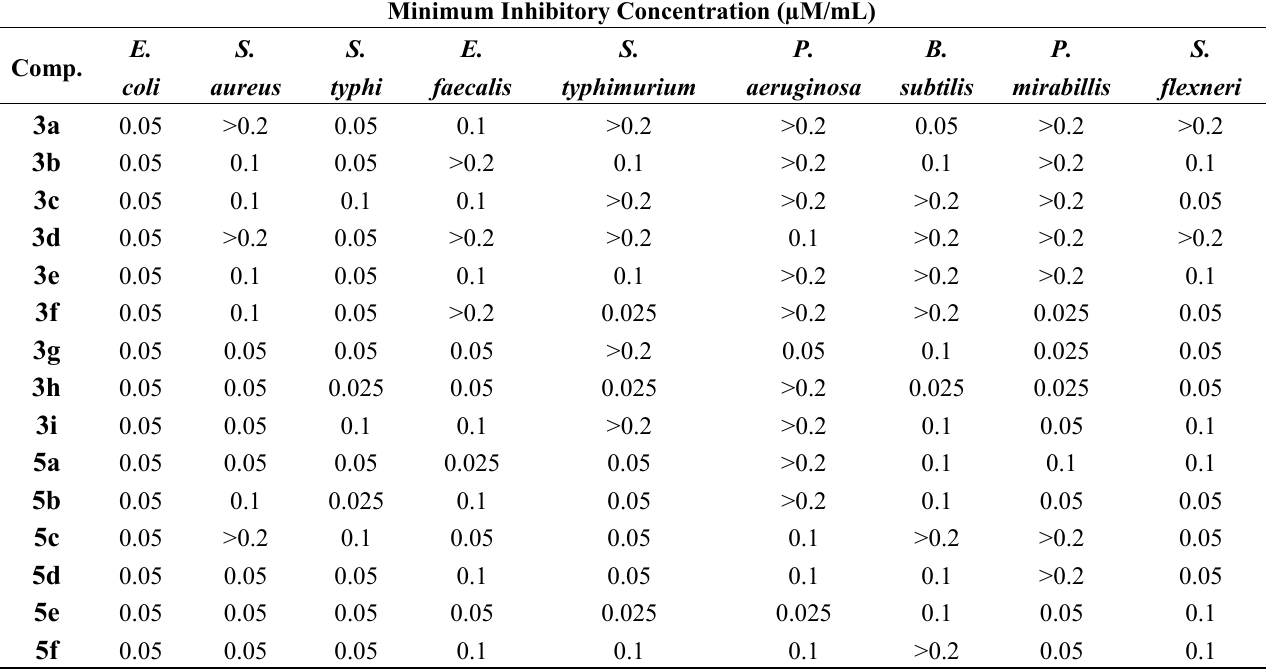
Table 3. Minimum inhibitory concentration of compounds 3a – i and 5a – f . Minimum Inhibitory Concentration